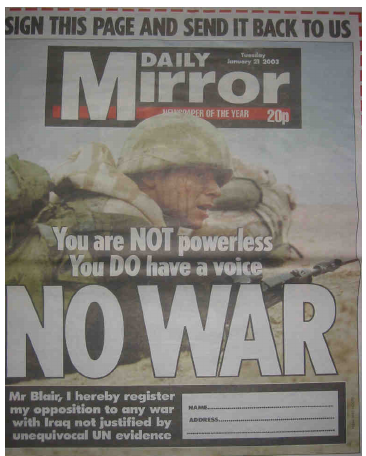
Figure 1. ‘You are not